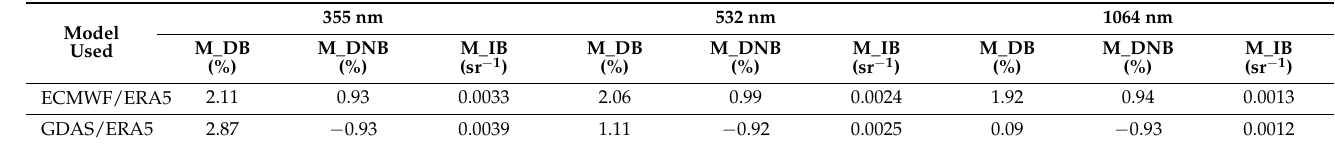
Table 9. Same as Table 8, but for two different forecast models compared with the corresponding reanalysis